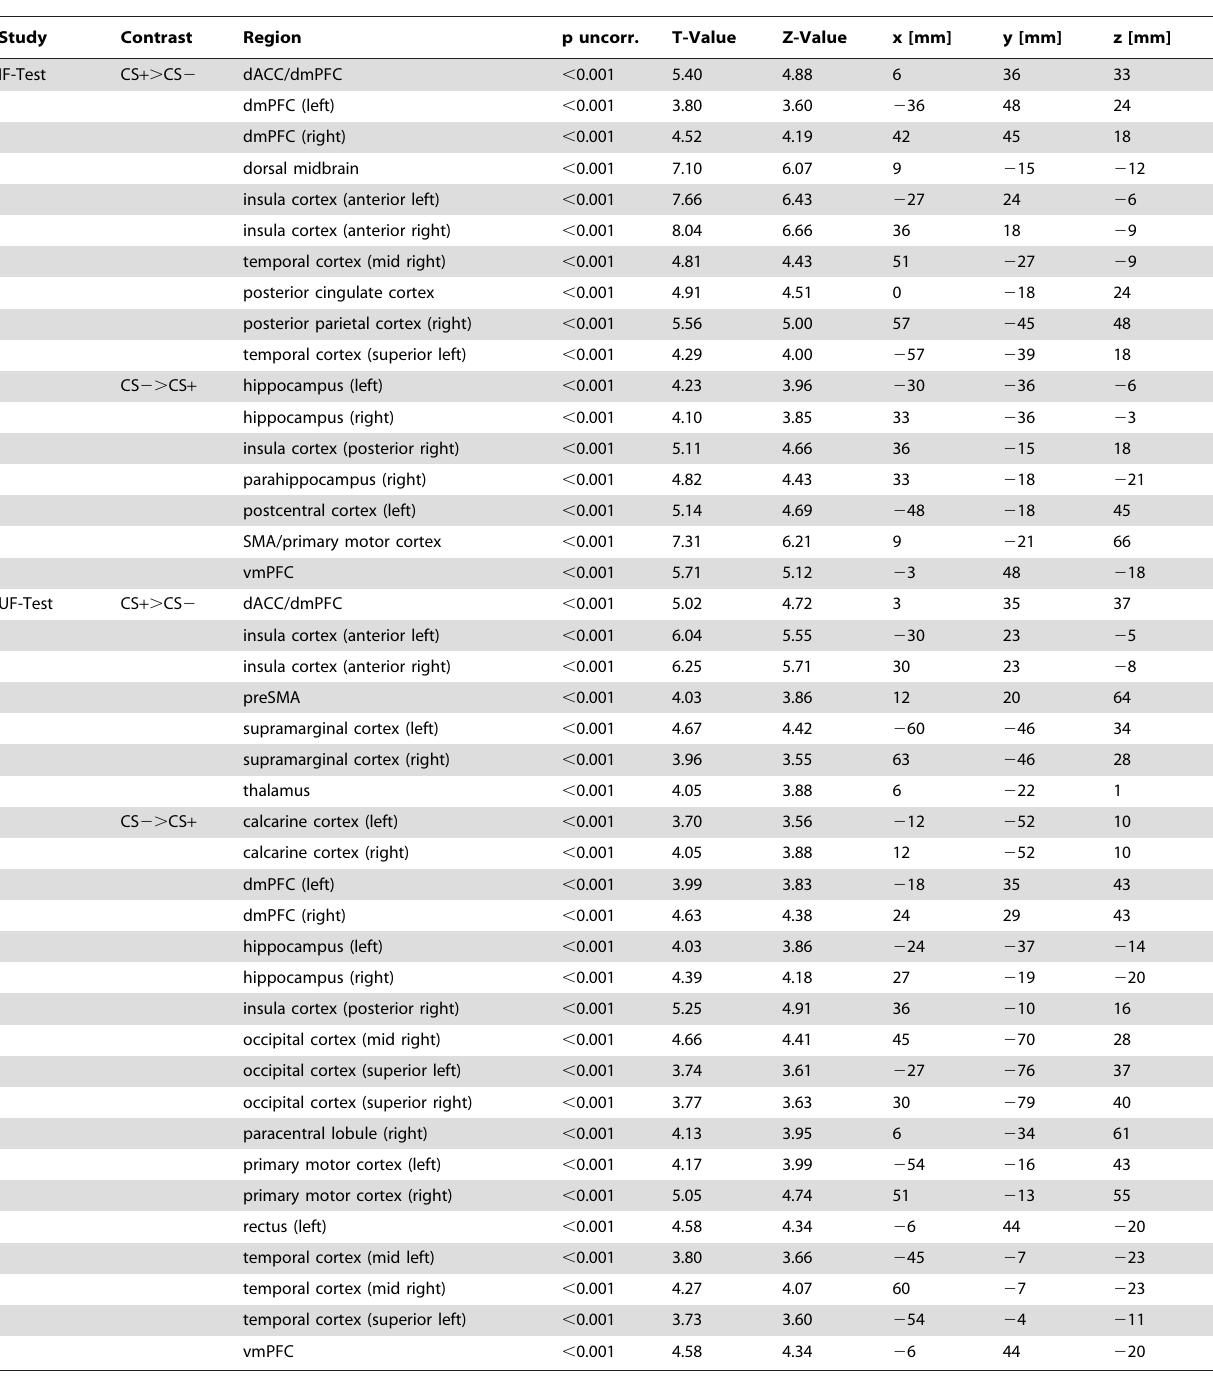
Table 1. Areas activated during Instructed and Uninstructed